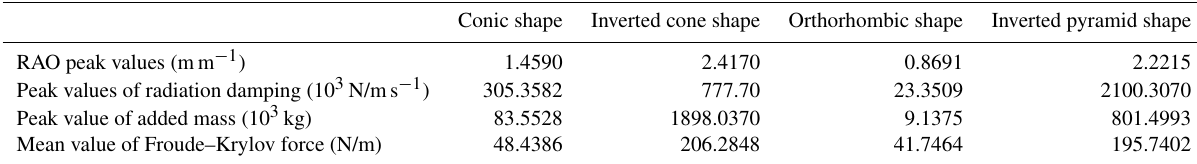
Table 4. Comparison of the energy efficiency between conical and pyramid floating bodies with different postures. Conic shape Inverted cone shape Orthorhombic shape Inverted pyramid